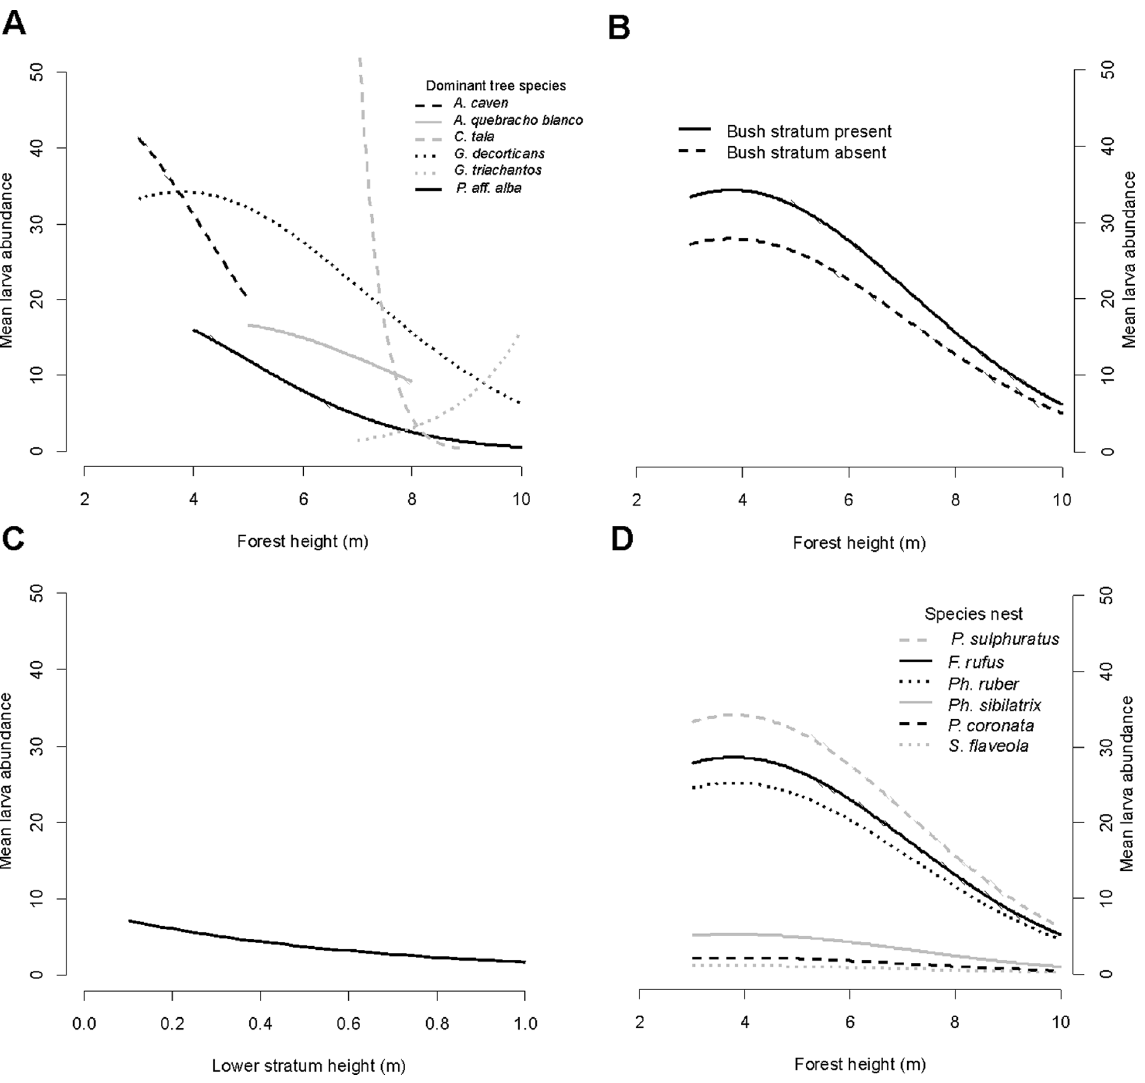
Figure 2. Mean Philornis abundance as predicted by the best microhabitat-level models. A) Relationship between average tree height and mean parasite abundance by dominant tree species. Prediction for Pi. sulphuratus broods. Each line spans the range of forest heights recorded for a particular dominant tree species; B) Effect of the presence of medium vegetation stratum (bush) on the mean parasite abundance. Prediction for Pi. sulphuratus broods in forests dominated by G. decorticans ; C) Effect of the low vegetation stratum (grass) height. Prediction for Pi. sulphuratus broods in forests dominated by G. decorticans ; D) Effect of the brood species on the mean parasite abundance. Prediction for forests dominated by G. decorticans . In all predictions, average values were used for continuous variables in the